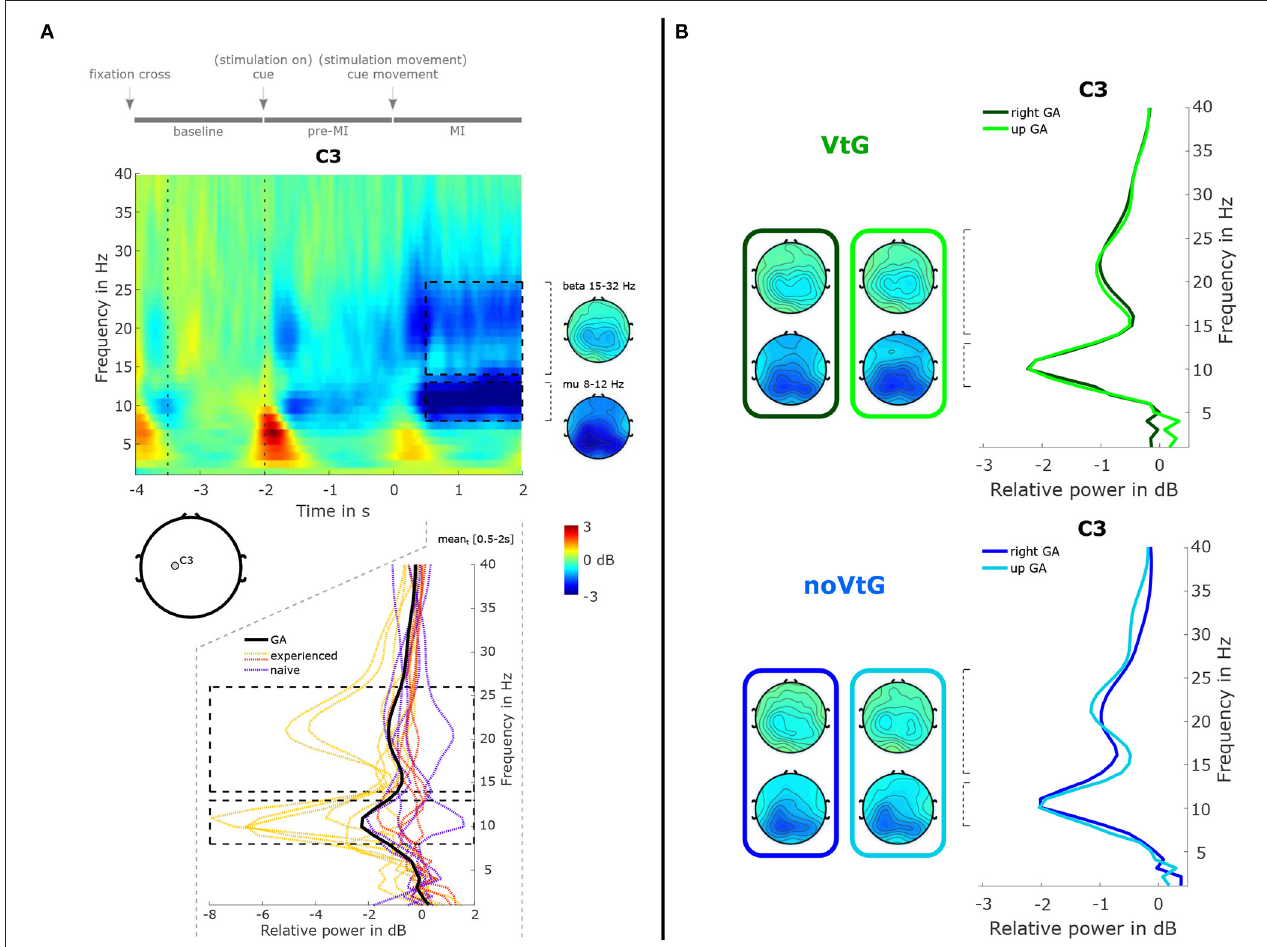
FIGURE 4 | Summary of spectral features. (A) Time-frequency decomposition of the grand-average trial, as time-frequency map, topographic plots, and power spectrum. The time-frequency decomposition and spectrum are computed relative to the period marked by dotted vertical lines in the time-frequency map. The time-frequency map and spectrum are depicted at location C3. The topographic plots were computed from the ranges marked by the black dashed lines in the time-frequency map, i.e., 0.5–2 s in the time dimension, and 8–12 Hz for the µ band, and 15–32 Hz for the β band in the frequency dimension. The bottom panel depicts the grand-average (black solid line) and single-subject spectra (colored dashed lines), respectively, during the MI period (0.5–2 s). The single-subject spectra are grouped into three subgroups, i.e., MI-experienced with stronger than average spectral peaks (yellow), MI-experienced with average or weaker µ peaks (red), and MI-naïve (purple). (B) Power spectra at C3 and topographic plots for the two conditions, and two directions. Green and blue colors identify the conditions. Spectra and topographic plots were computed from the same ranges marked in (A)